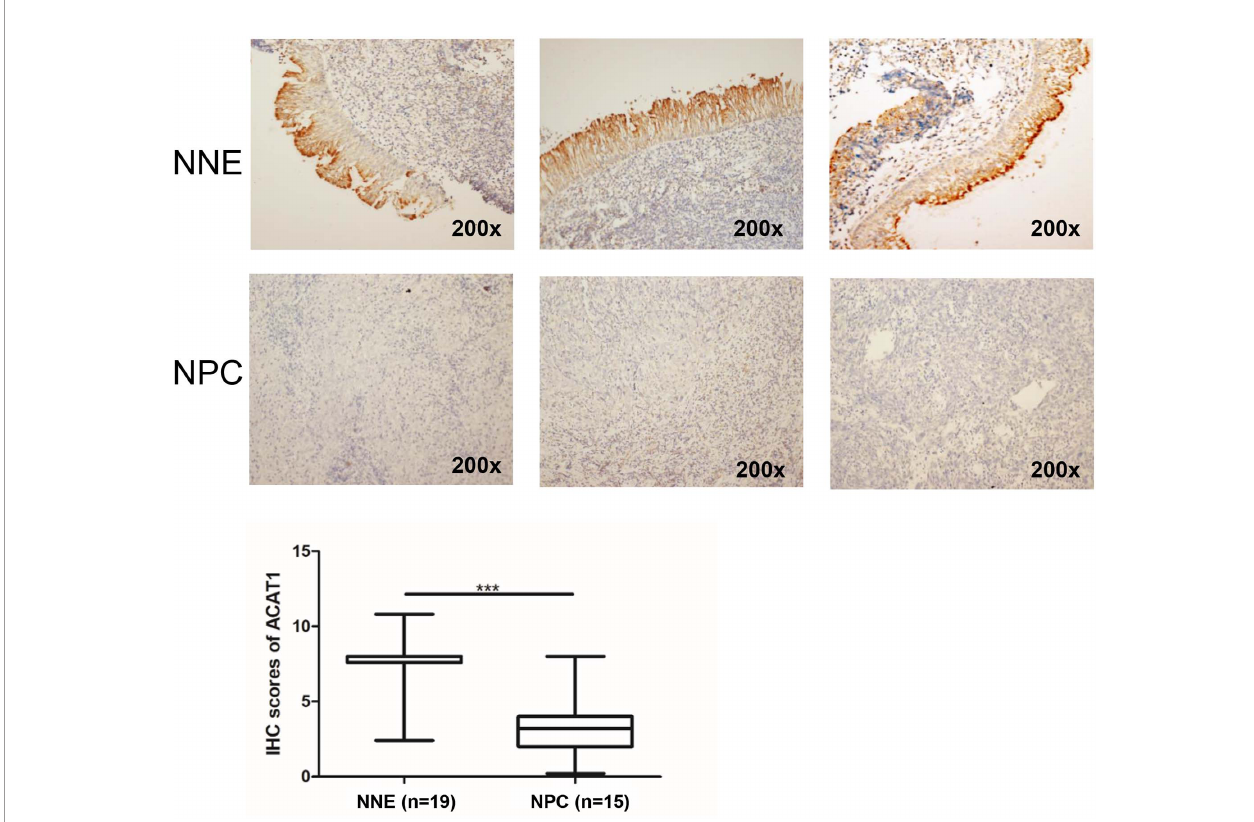
FIGURE 2 | Immunohistochemical staining of ACAT1 in NNE tissue (n=19) and NPC (n=15). Magni fi cations ×200. The independent Student ’ s t-test was used to analyze the results. The line inside the boxes represents the median value. The box length indicates the interquartile range. *** p <